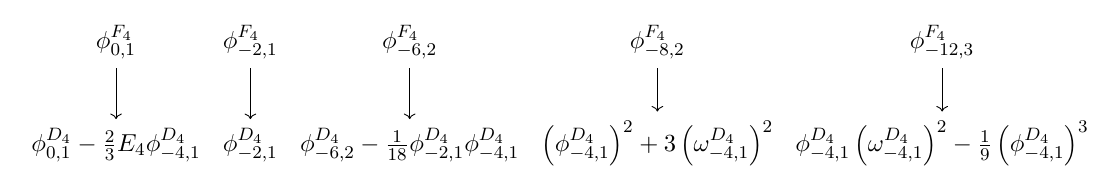
Figure 3 . The specialization of J ( F 4 ) to J ( D 4 ) generators. The vertical lines correspond to composition via an isomorphism of the two lattices which is given explicitly in appendix D.5.